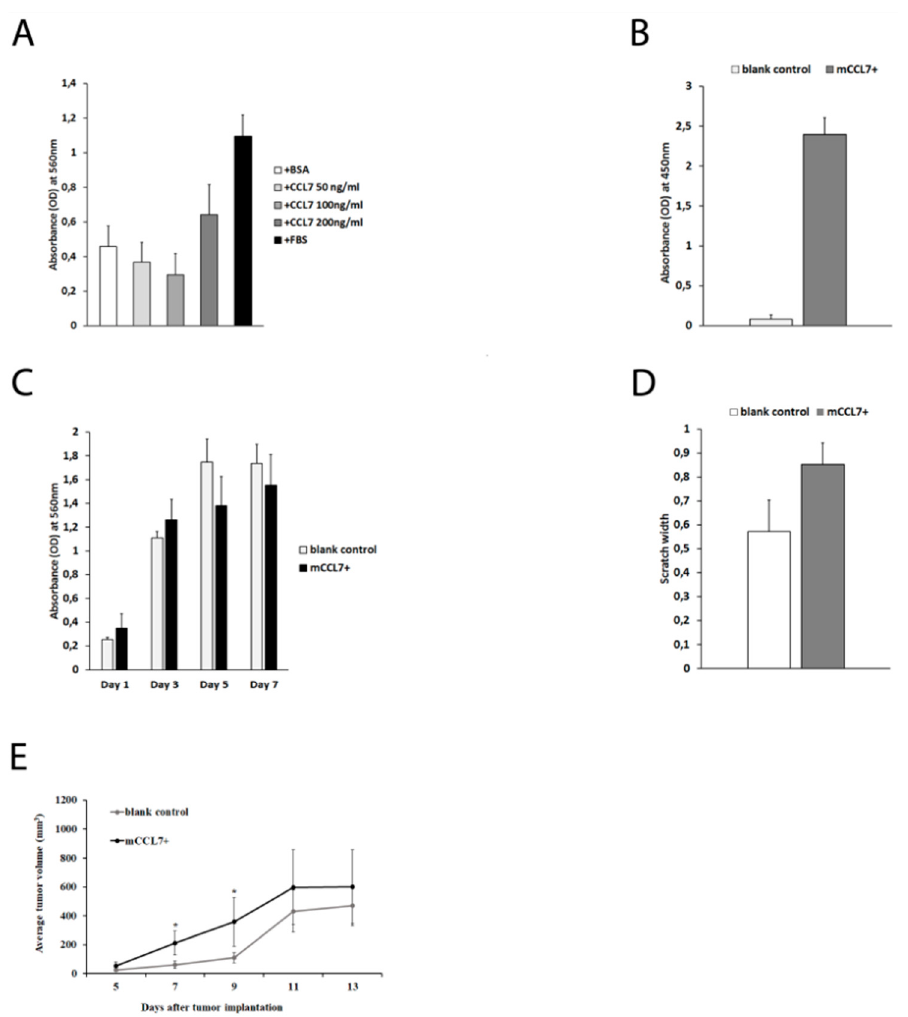
Figure 2. Effect of CCL7 overexpression on tumor growth: ( A ) proliferation of CT26 cells subject to recombinant CCL7; ( B ) overexpression of CCL7 in mCCL7+ cell line (ELISA for CCL7); ( C ). CT26 tumor cell proliferation (blank control vs. mCCL7+) (MTT assay); ( D ) scratch assay on same cell lines; and ( E ) CT26 tumor growth (blank control vs. mCCL7+) in BALB/c mice ( n = 15 mice per group).